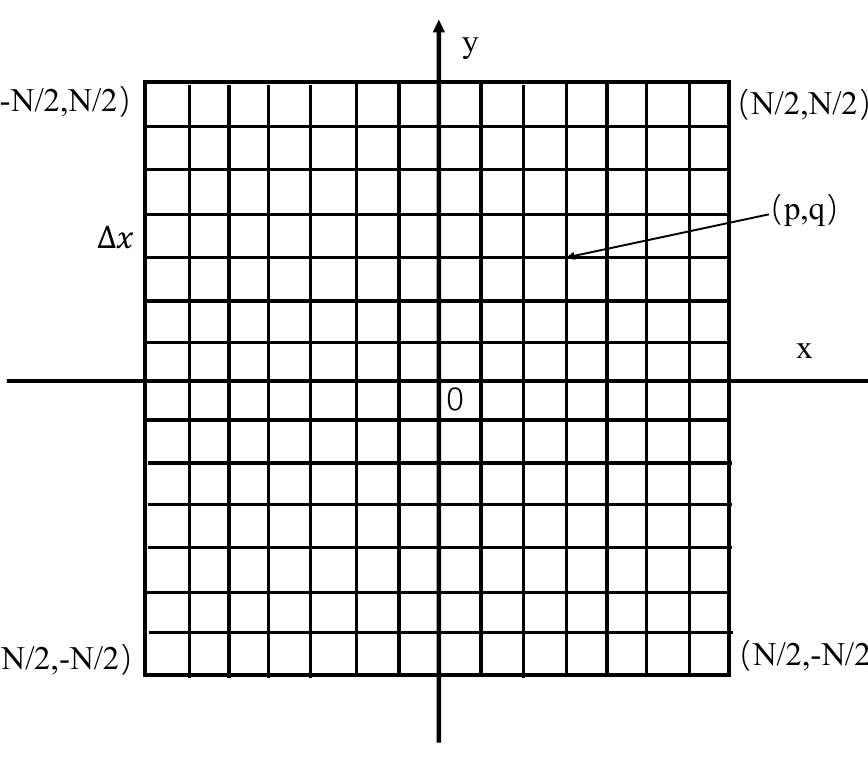
Figure 5. Schematic diagram of phase screen grid simulation.